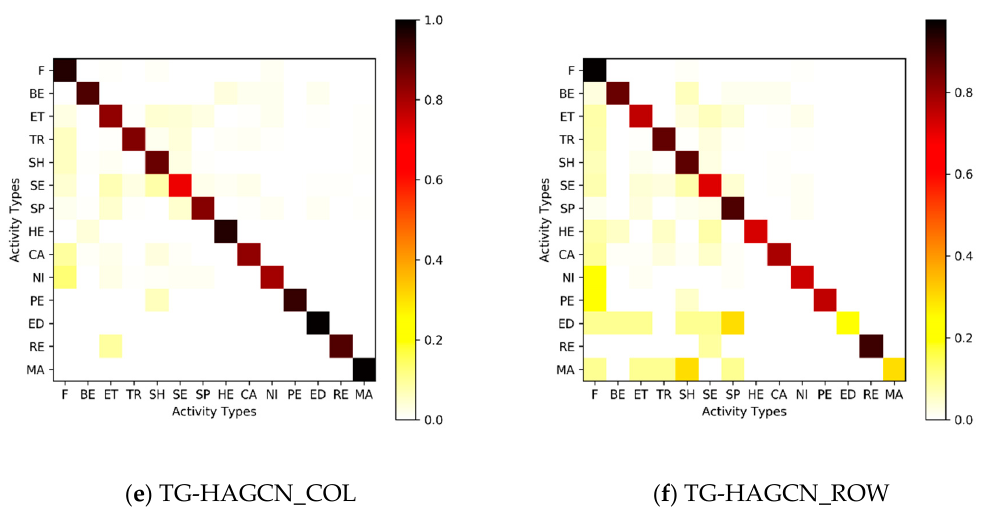
Figure 3. Heat maps of activities for the models. Since it is an unbalanced dataset, we have performed column-wise normalization (COL) and row-wise normalization (ROW) on the original heat maps. The values on the diagonal of “COL” correspond to precision score, and the values on the diagonal of “ROW” correspond to recall score.